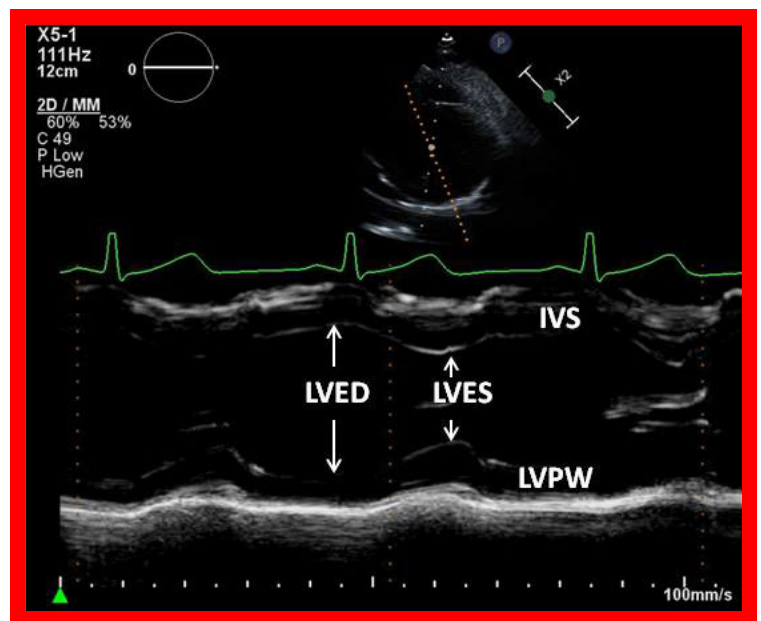
Figure 17. Selected video frame showing left ventricle in end diastole (LVED) and in end systole (LVES) demonstrating normal function. IVS, interventricular septum; LVPW, left ventricular posterior wall.